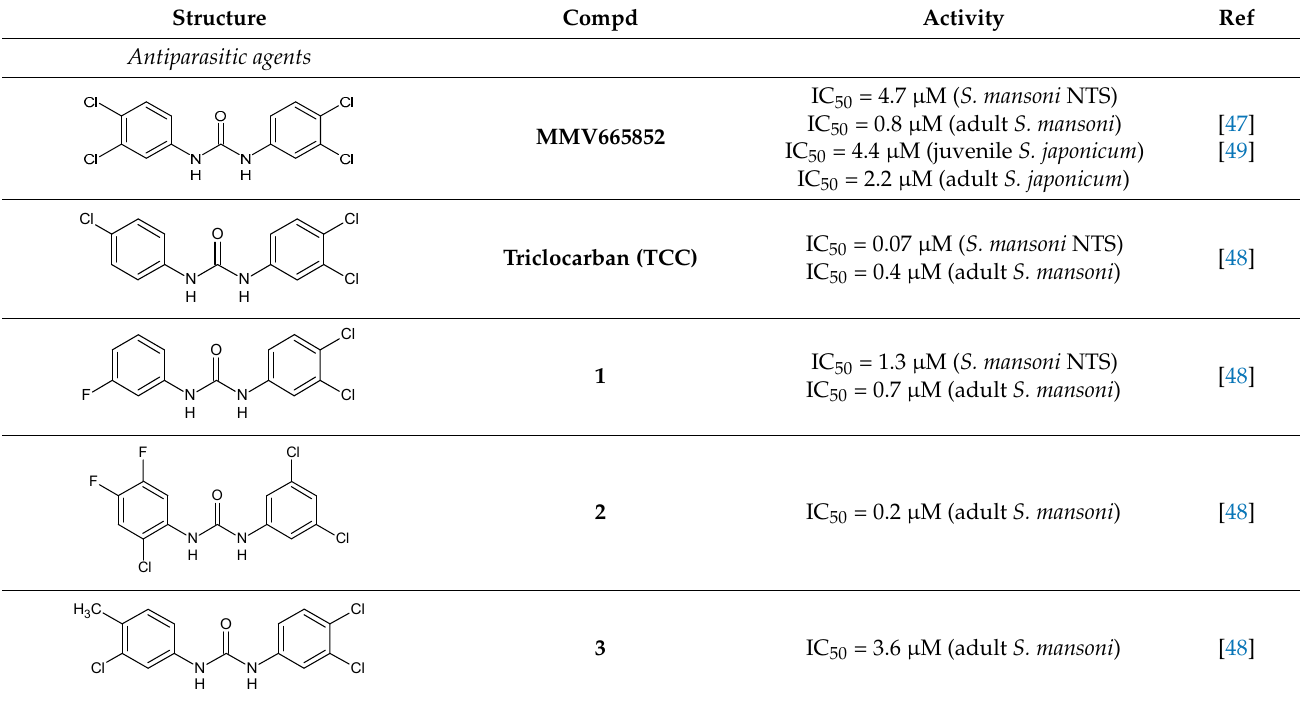
Table 1. Diarylureas as antiparasitic agents.